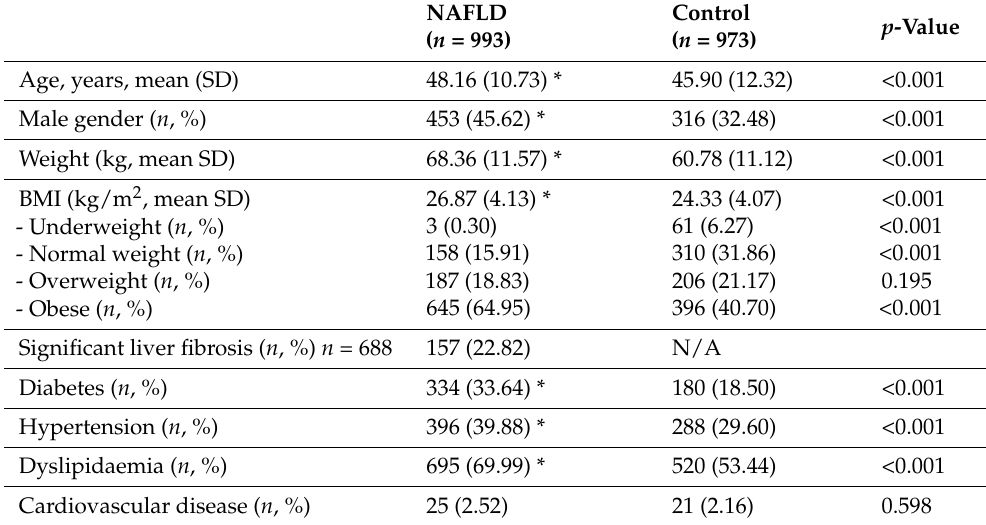
Table 1. Baseline characteristics of the